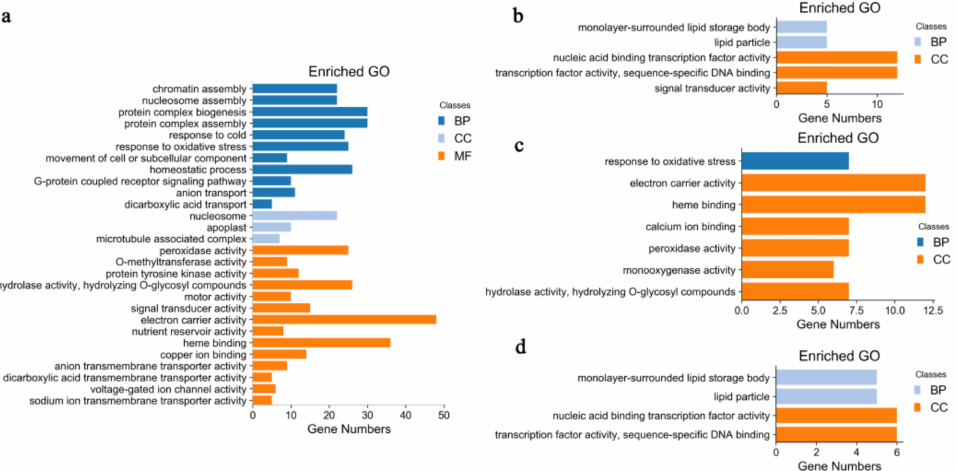
Figure 2. Gene-ontology functional-enrichment analysis of DEGs detected in maize embryos. ( a , b ) Significant GO terms associated with up- and downregulated DEGs, respectively, detected between DS and UG. ( c , d ) Significant GO terms associated with up- and downregulated DEGs, respectively, detected only in